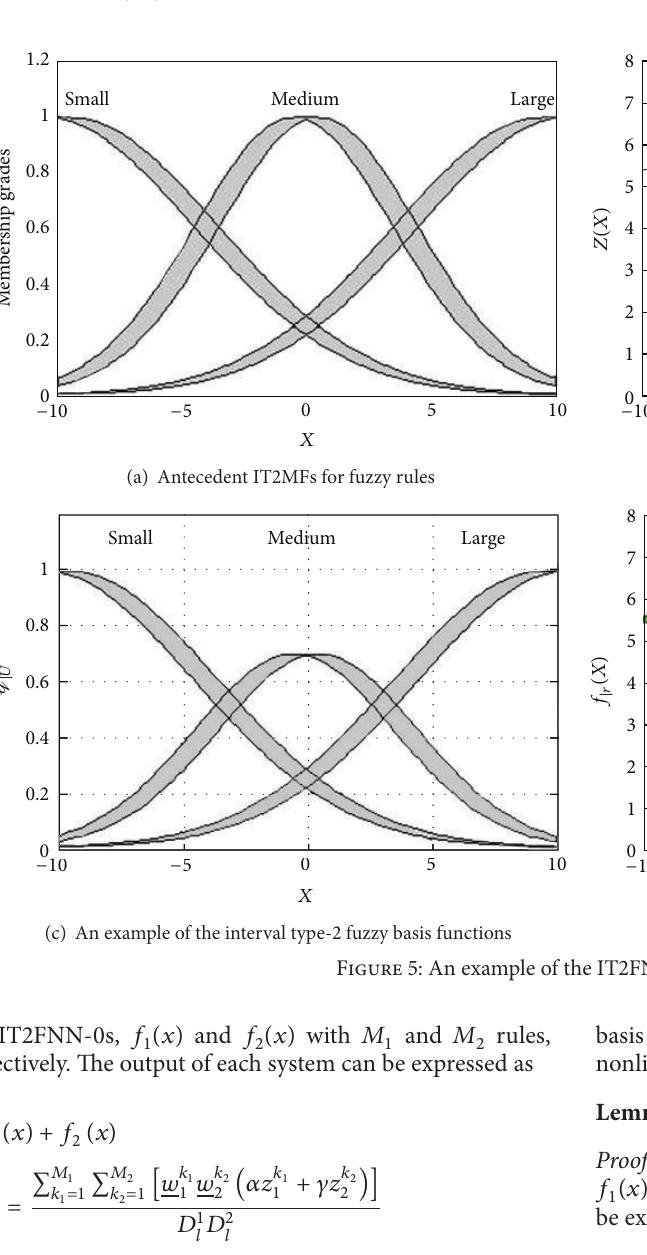
(b) Overall I/O curve for crisp rules